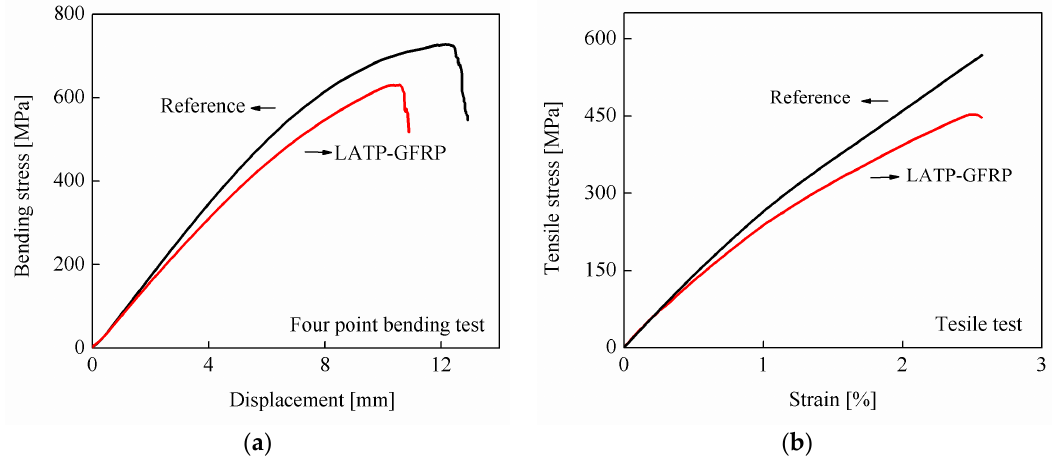
Figure 9. ( a ) Curves of four-point bending tests; ( b ) curves of tensile tests of the GFRP composite specimens with and without LATP pellets.